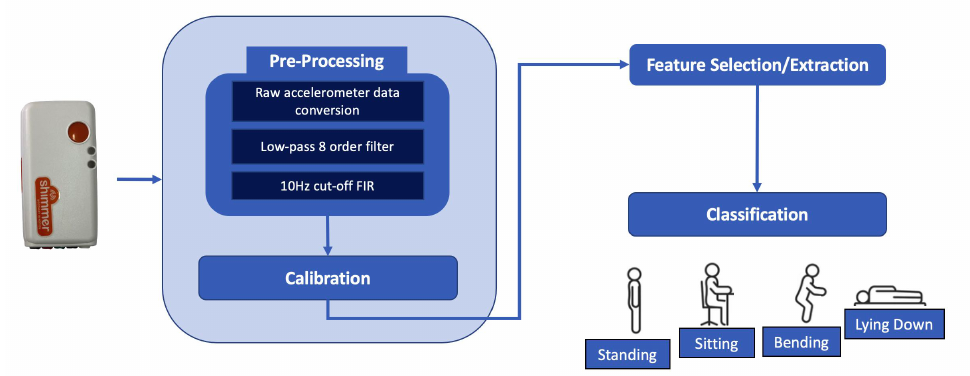
Figure 1. Main steps of software framework via a block diagram.